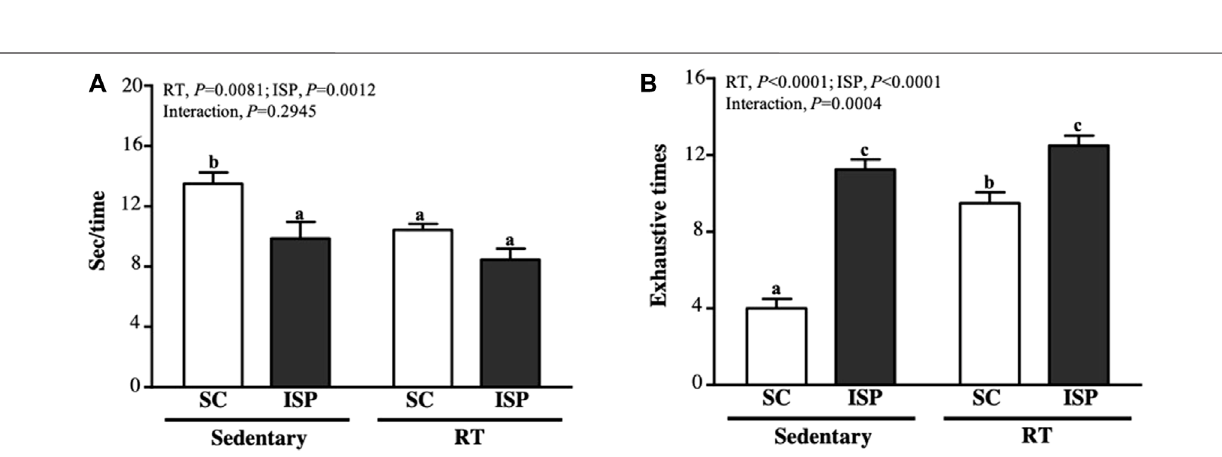
Frontiers in Physiology |